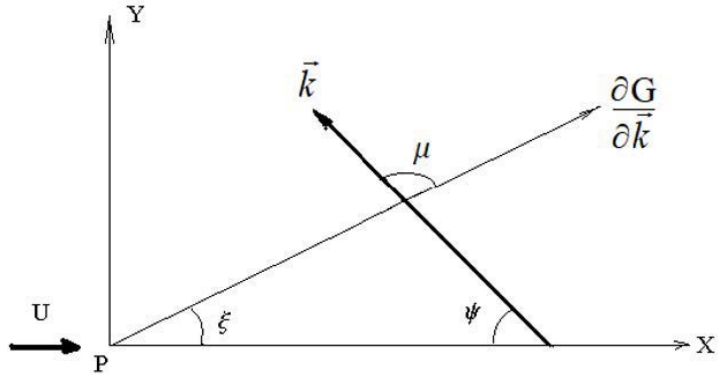
→ → U is the flow velocity, k —wave number vector of ∂ G (cid:1) = (cid:0) G → k X , G k Y G  k ∂   , G G  expresses the ray direction ( k ) / G ( k ) X , k Y X , k Y k X Y k  X Y k k ,k )